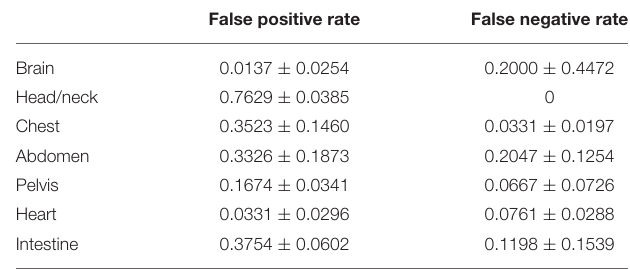
TABLE 1 | Coverage rate, false-positive rate, and false-negative rate of the new combination method.